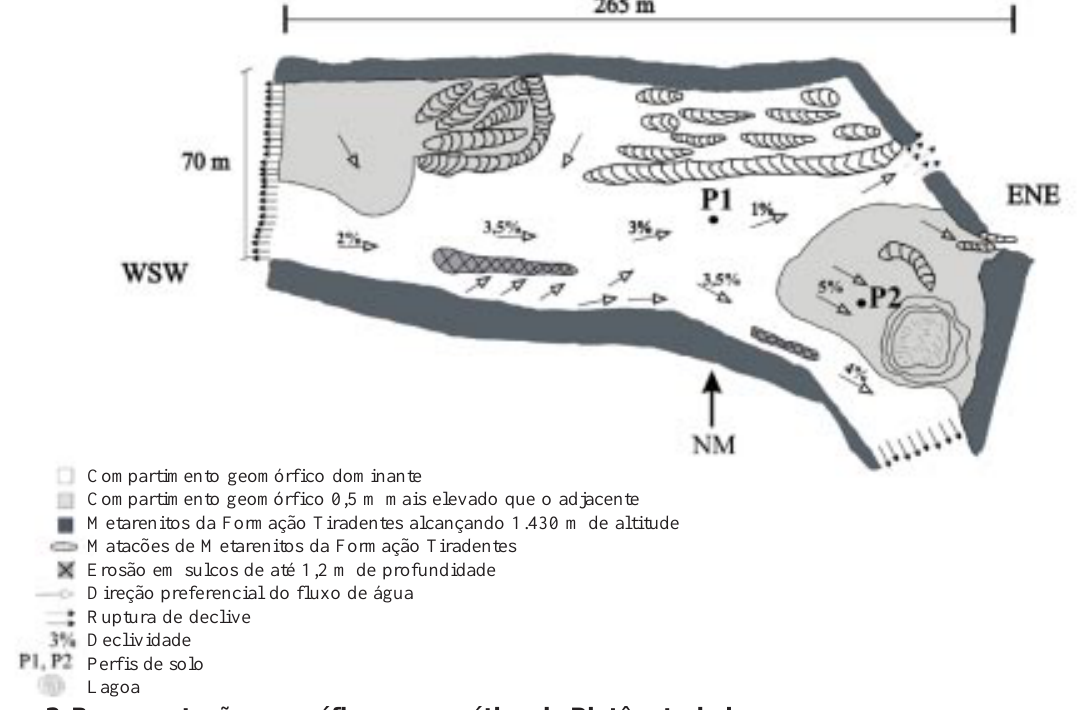
Figura 2. Representação geográfica esquemática do Platô estudado.